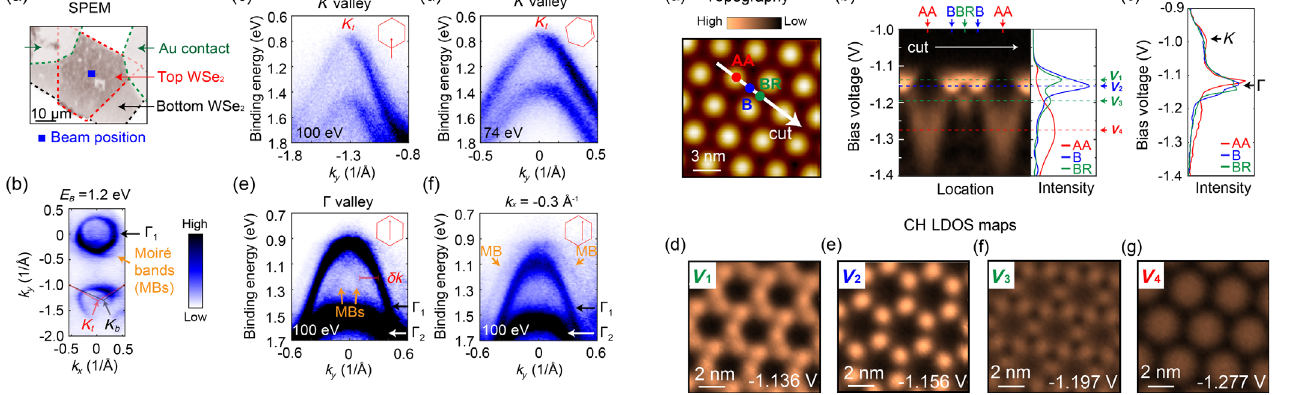
FIG. 3. STM measurement on TB WSe 2 . (a) Definition of high- symmetry sites in TB WSe 2 superlattice. Here, AA (indicated by the red point) means eclipsed stacking sites with Watoms over W atoms, BR (indicated by the green point) means the bridge that connects neighboring AA sites, and B (indicated by the blue point) stands for Bernal stacking, including two inversed con- figurations with Watom over Se atom ( B ) or Se atom over W W = Se atom ( B ). The white arrow indicates the direction of dI=dV Se = W spectra shown in (b). (b) Left: dI=dV spectra measured in constant height mode (CHSTS) along AA-B-BR-B-AA direction. The positions of AA, B, BR sites are indicated by arrows of corresponding colors. Right: representative dI=dV curves on AA (red), B (blue), and BR (green) sites. The peak positions in AA ( V 4 ), B ( V 2 ), and BR ð V 1 ; V 3 Þ curves are marked by dashed lines of corresponding colors. (c) dI=dV curves measured in constant current mode (CCSTS) on AA, B, and BR sites. Black arrows indicate dI=dV signal contributed by Γ and K valleys, respec- tively. (d) – (g) LDOS maps (in CH mode) corresponding to the peak positions in the AA ( V 4 ), B ( V 2 ), and BR ð V 1 ; V 3 Þ curves, respectively. During the LDOS mapping, the tip height was ¼ − 1 . 6 V with I ¼ 170 adjusted at V bias